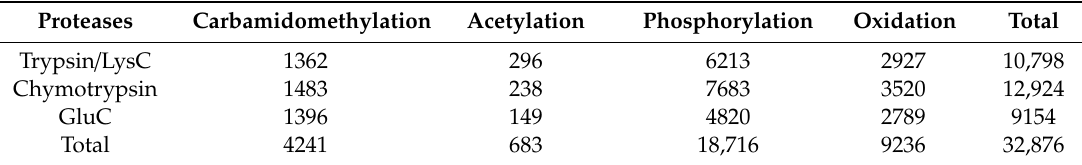
Table 3. Number of fixed and dynamic PTMs per